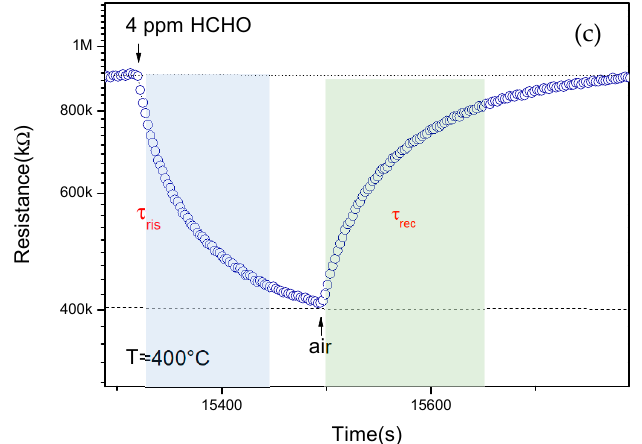
Figure 6. ( a ) Sensing tests of 3Al,3Ca-doped ZnO sensor to 4 ppm HCHO at different temperature; ( b ) Dynamic response of the sensor to 0.125 ppm HCHO at 400 °C, showing the response and recovery time; ( c ) Dynamic response of the sensor to 4 ppm HCHO.